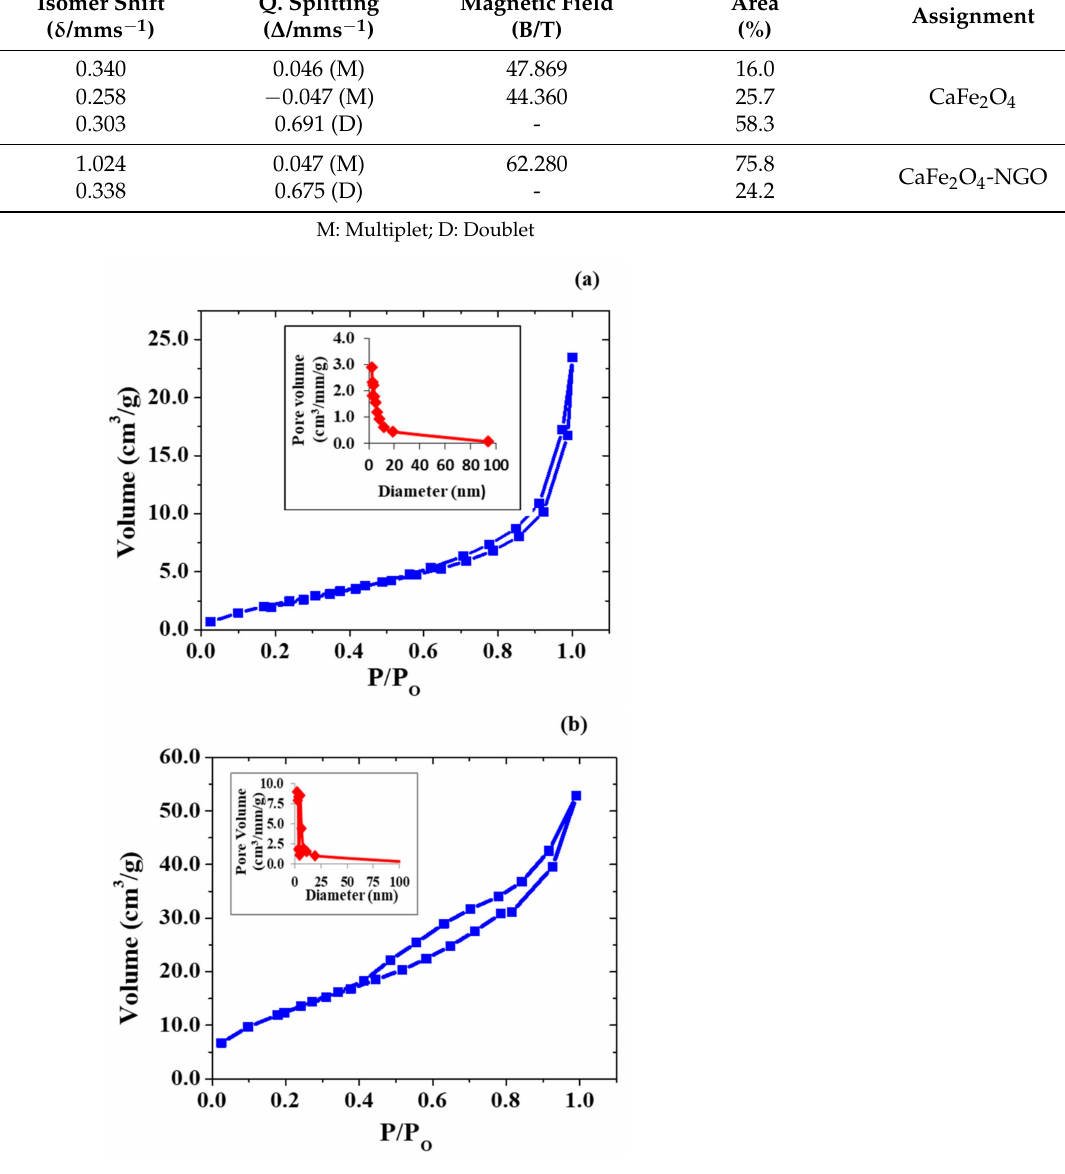
Figure 4. N 2 adsorption desorption isotherms and corresponding pore size distribution (inset) of